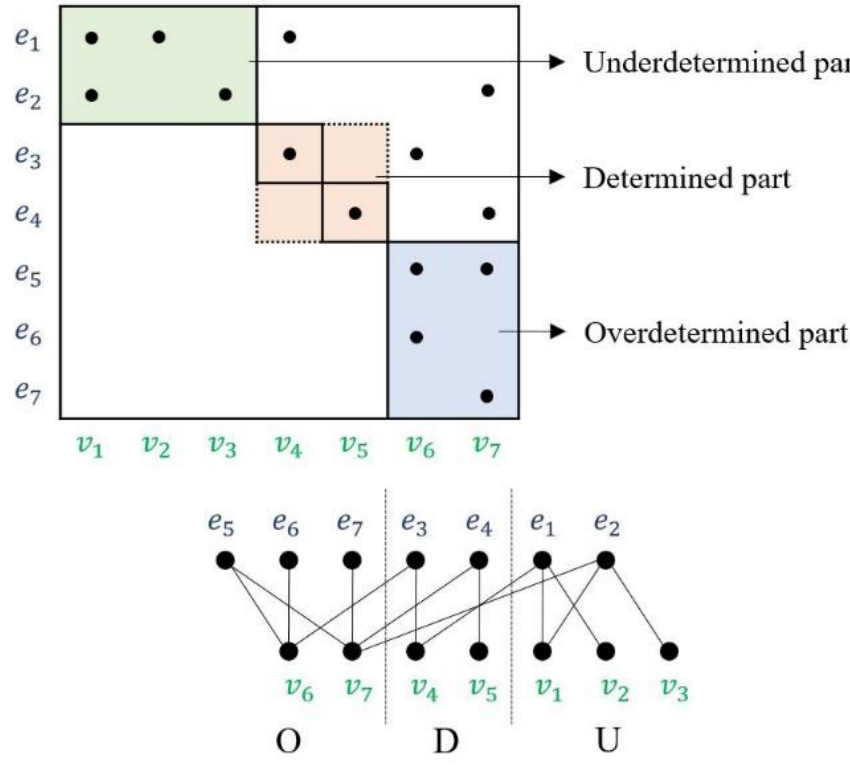
Figure 5. Dulmage – Mendelsohn decomposition. Figure 5. Dulmage–Mendelsohn